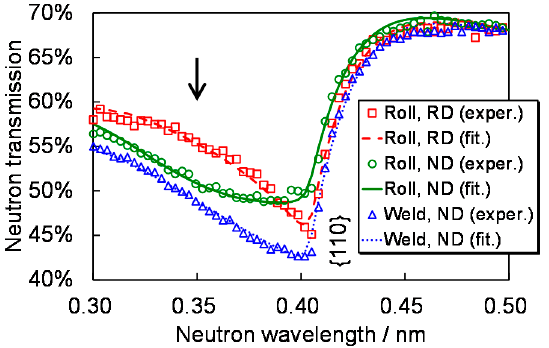
Figure 5. Three types of Bragg-edge transmission spectrum with the fitting curves [1]. Due to the texture effect and the extinction effect, spectrum shape and spectrum intensity are changed. From these profile changes, degree of crystallographic anisotropy, preferred orientation and crystallite size are quantitatively deduced.